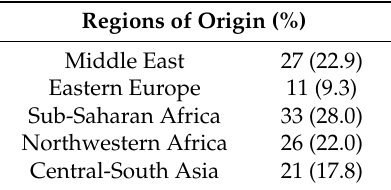
Table 2. Regions of origin for asylum seekers ( n = 119).